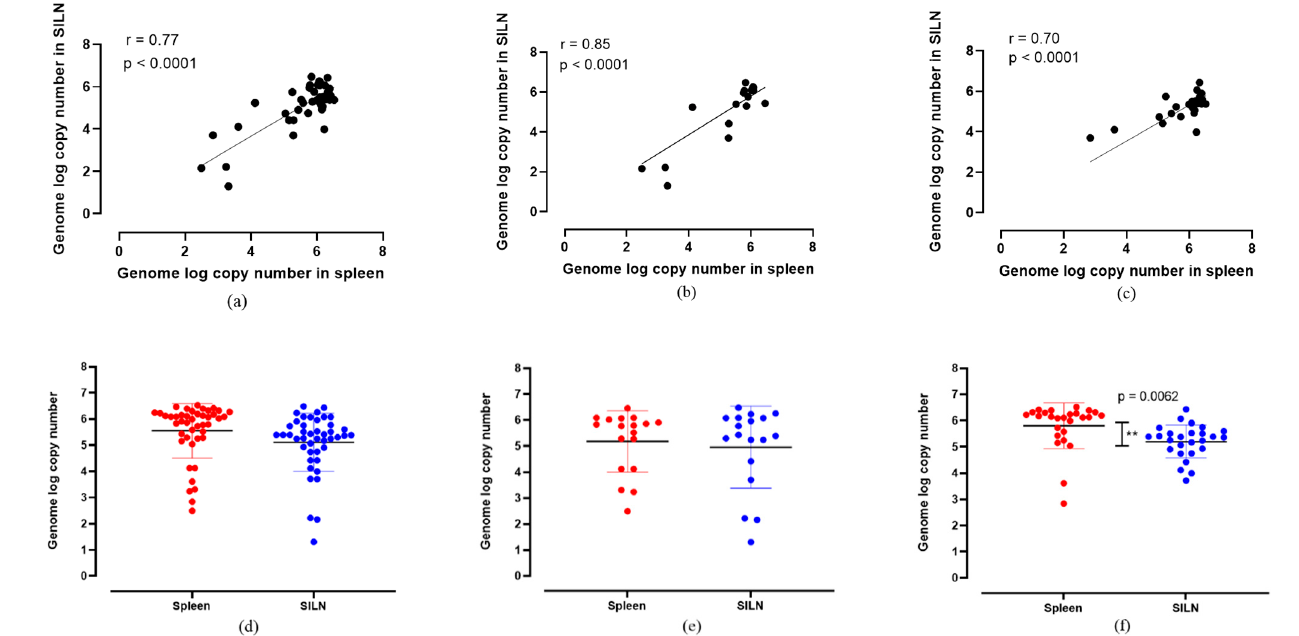
Figure 2. Correlation of ASFV genome log copy numbers detected between spleen and SILNs together with the scatter dot plots indicating the relative distribution of detection levels in all ASF strains collectively ( a , d ), ASF Estonia only ( b , e ) and highly virulent ASF strains ( c , f ). The ASF genome log copy numbers detected in spleens and SILNs correlated positively ( r = 0.77, r = 0.85 and r = 0.70) at statistically significant levels ( p < 0.0001). When the unpaired t-test was performed, there was no significant difference between mean genome log copy numbers, except among the highly virulent ASF strains, where the mean genome log copy numbers were significantly different ** ( p =